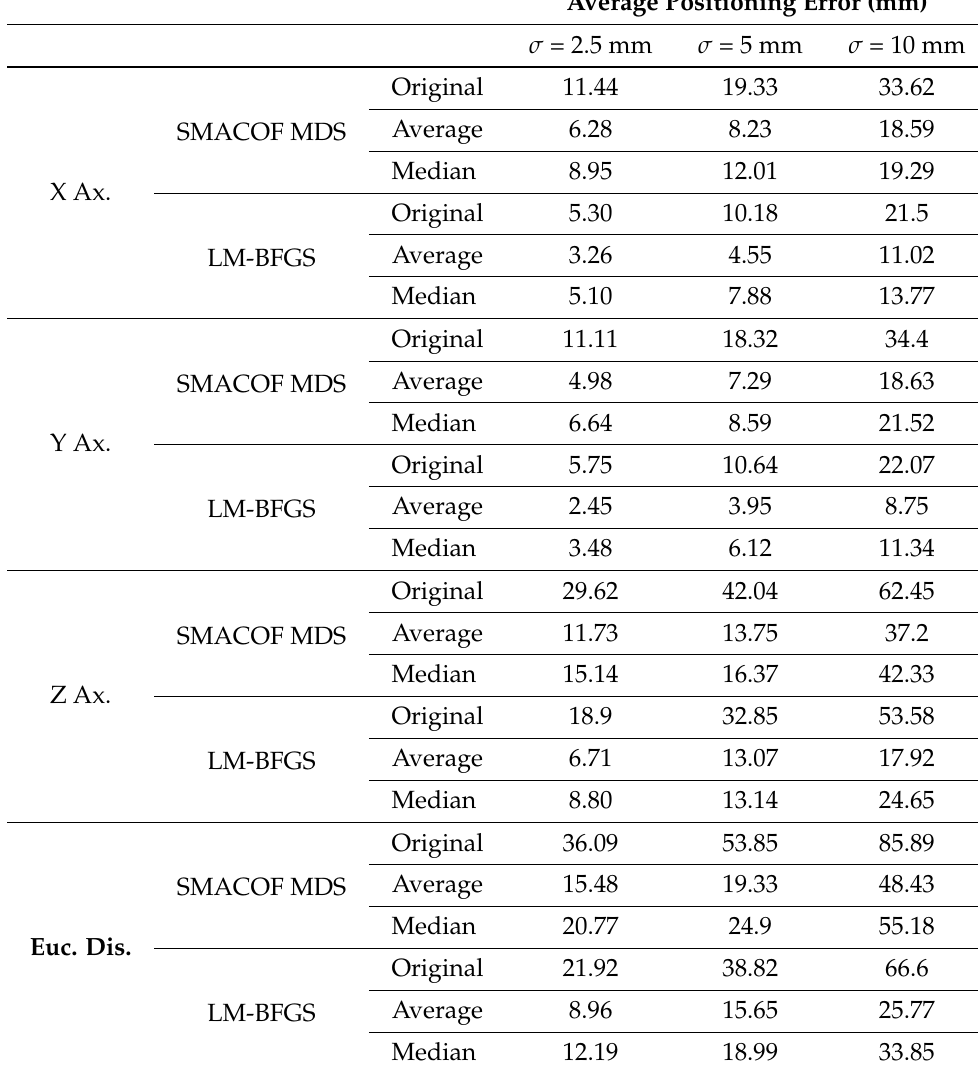
Table 5. Average trajectory error for the loop XY gesture, with no smoothing (Original) and with 11th order ( M = 11) moving-average (Average) and moving-median (Median) smoothing filters, for SMACOF MDS and LM-BFGS optimization